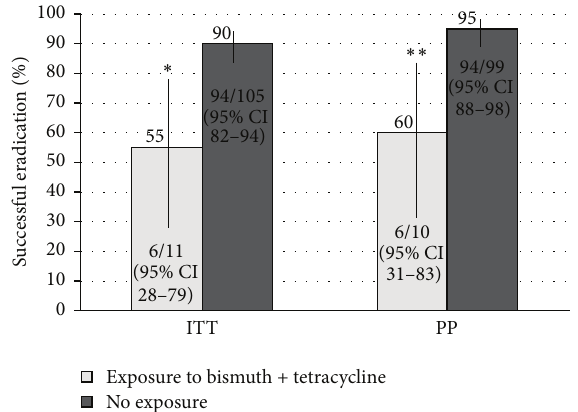
Figure 8: Eradication with bismuth quadruple therapy based on previous exposure to tetracycline and bismuth containing H. pylori treatments. ∗ 𝑝 < 0.01 , ∗∗ 𝑝 < 0.001 for exposure versus no exposure. Risk difference: 35% (PP, 95% CI: 11–64) and 35% (ITT, 95% CI: 10–